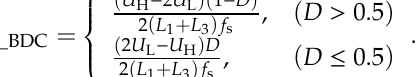
Table 2. Two arms complementary series coding.